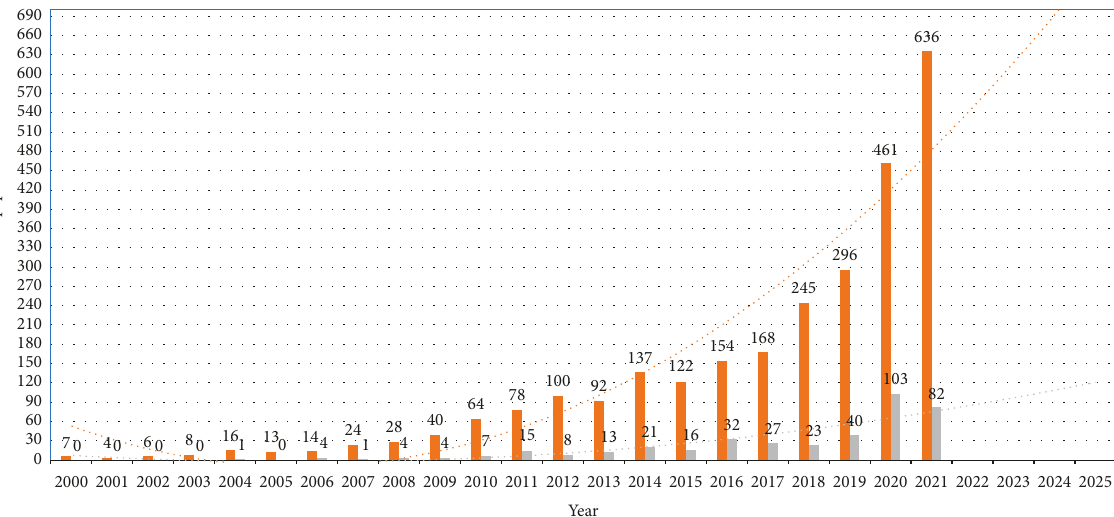
Figure 2: Annual number and trends of papers of DEM